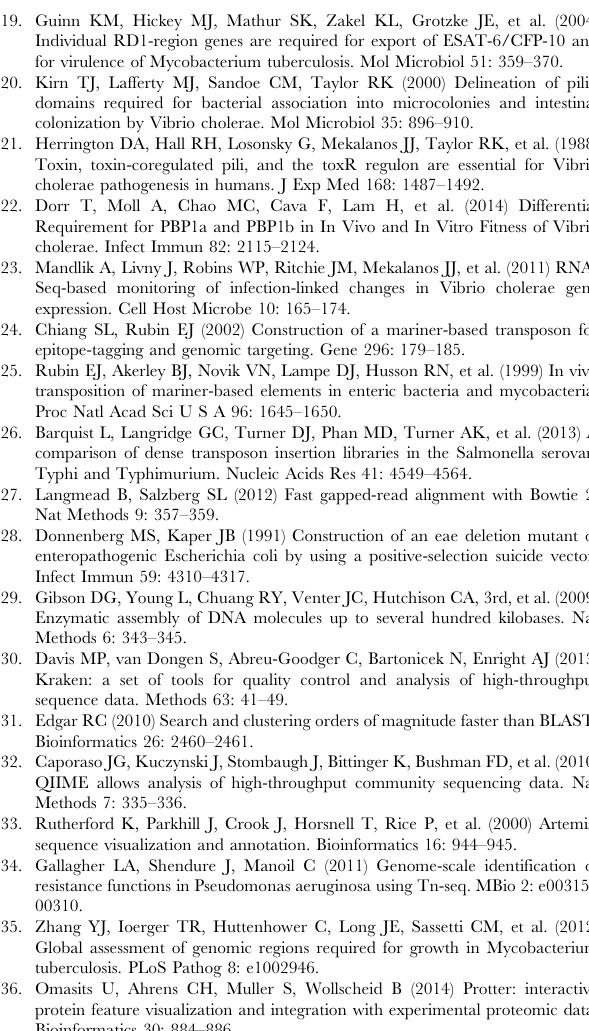
Table S5 Total read counts from in vitro and rabbit-passaged libraries for every potential insertion site in V. cholerae . The total reads counts from in vitro and rabbit-passaged V. cholerae TIS libraries were mapped to all TA dinucleotides in the genome and assigned to a specific locus. Table S6 Primer sequences for constructing in frame gene deletions in V. cholerae . Text S1 The ARTIST user manual. The user manual provides background knowledge on the ARTIST pipeline and detailed